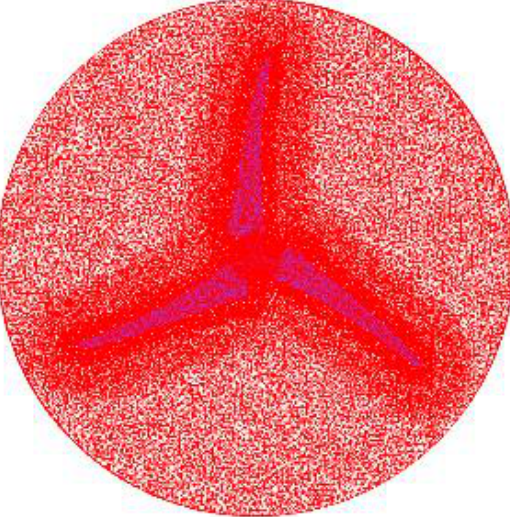
6 of 20 Figure 3. Grid of the computational stationary domain.